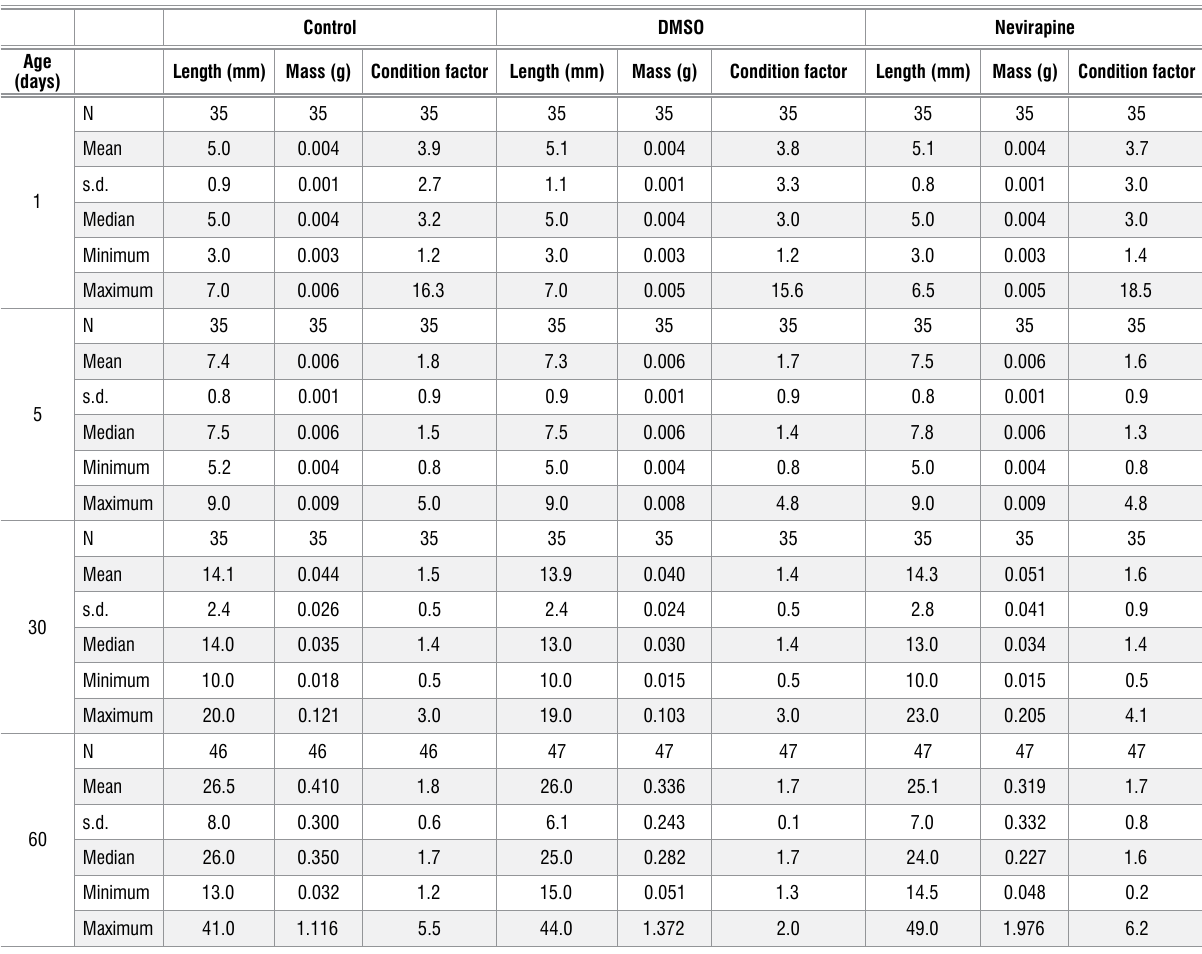
Table 1: Mean total length, mass and condition factor of control fish exposed to borehole water (Control) or the solvent dimethysulfoxide (DMSO) and of nevirapine-exposed fish Control DMSO Nevirapine Mass